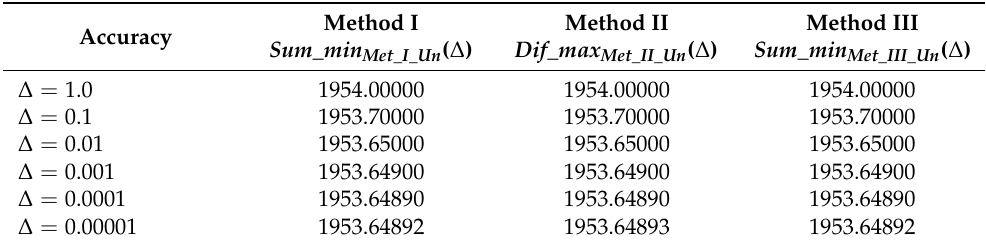
Table 9. Estimated lines lengths d ∆ of the reconstructed image for a given accuracy ∆ using the methods proposed by the authors.